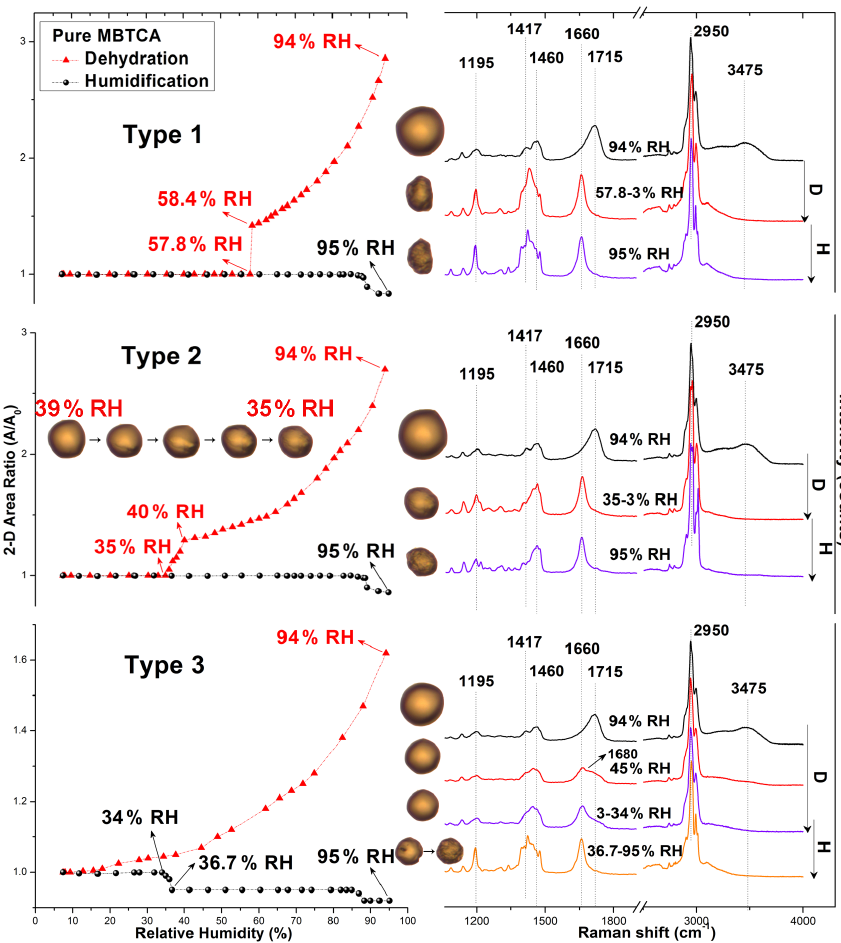
Figure 2. Hygroscopic curves, corresponding optical images, and Raman spectra at specific RHs of three types of pure MBTCA particles. The transition RHs recorded during the dehydration (D) and humidification (H) processes are marked with arrows in the hygroscopic